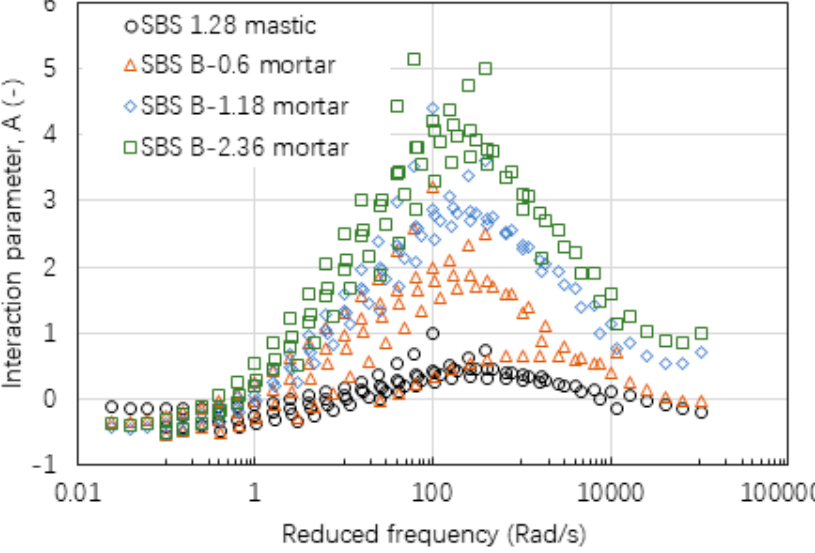
Figure 11. Interaction parameter of A values of mastic and mortar based on AC-13 mixture.